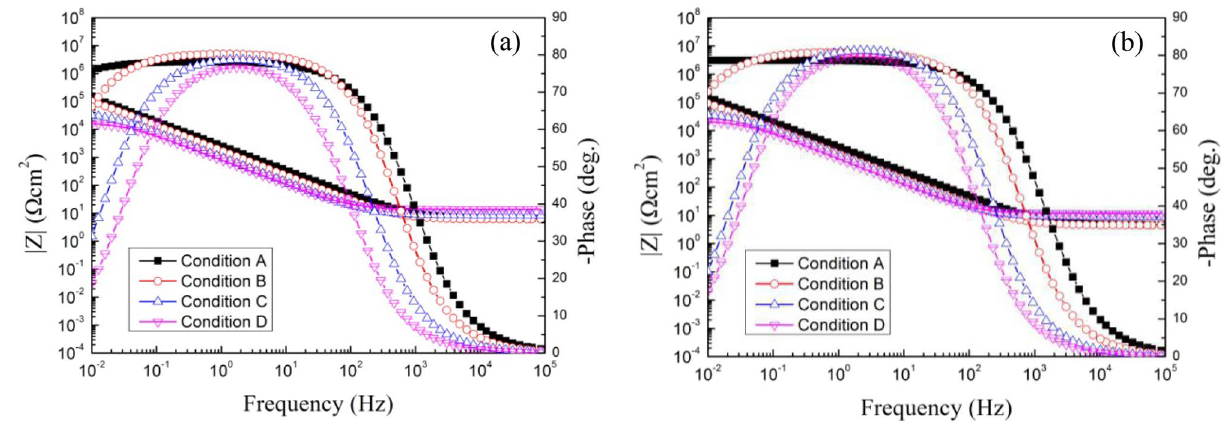
Figure 4. Bode diagrams for tested titanium alloy samples under various test conditions: ( a ) Ti-6Al-4V and ( b )